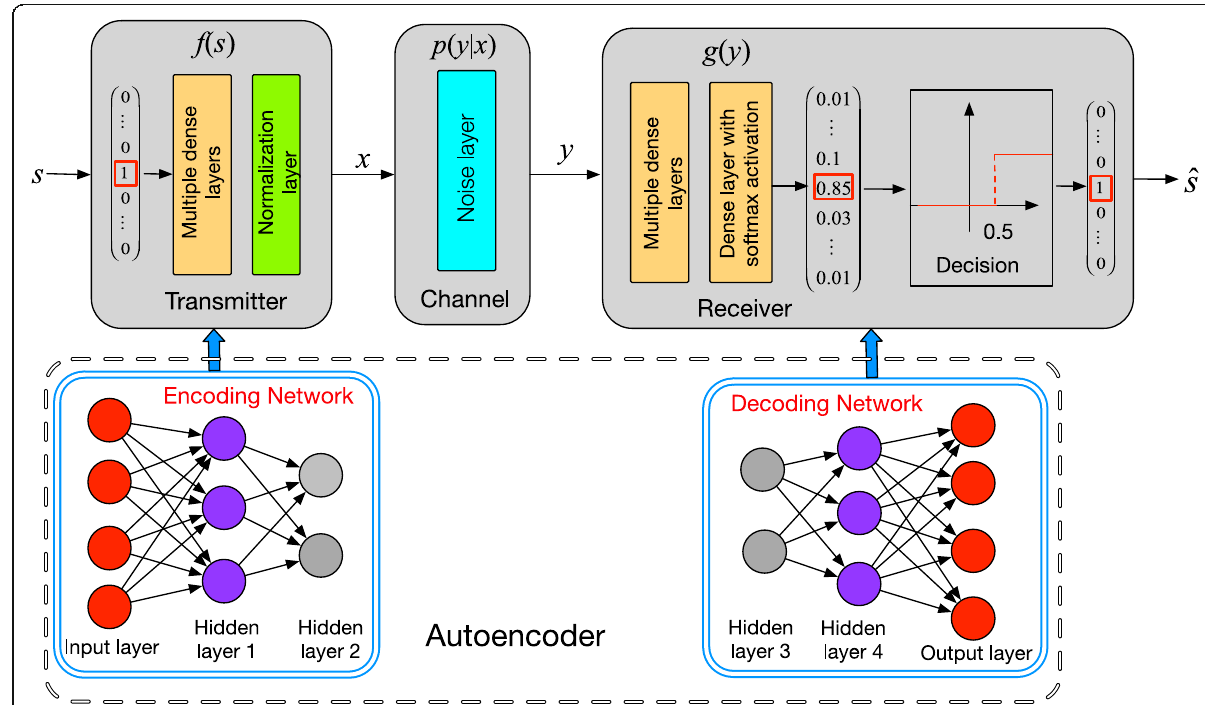
Fig. 1 Autoencoder-based communication